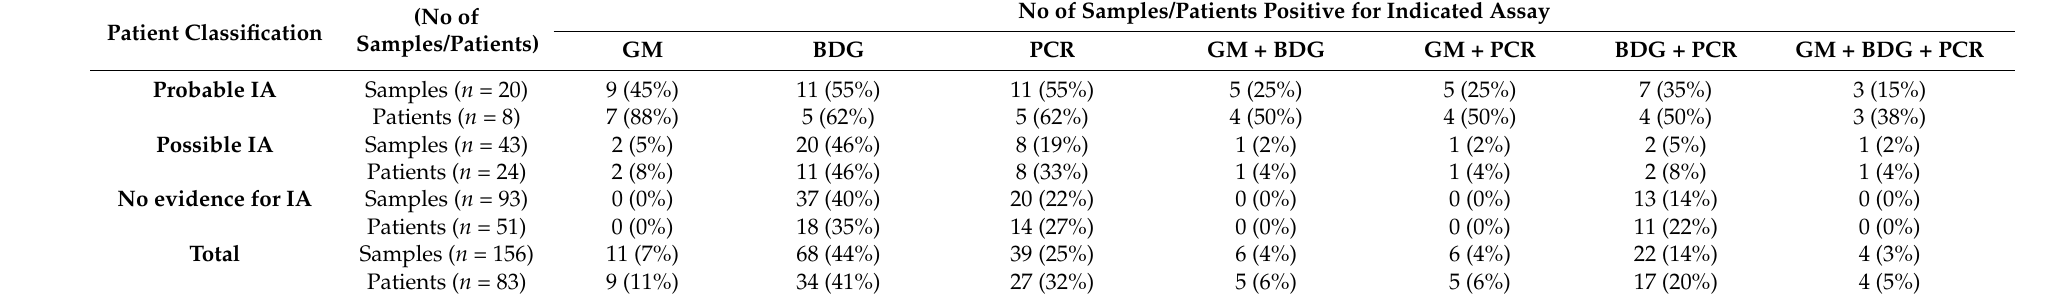
Table 1. Positivity rates of galactomannan (GM), 1,3- β -D glucan (BDG) and Aspergillus polymerase chain reaction (PCR) assays in patients with probable, possible and no invasive aspergillosis (IA) with respective to the European Organization for Research and Treatment of Cancer-Invasive Fungal Infections Cooperative Group/National Institute of Allergy